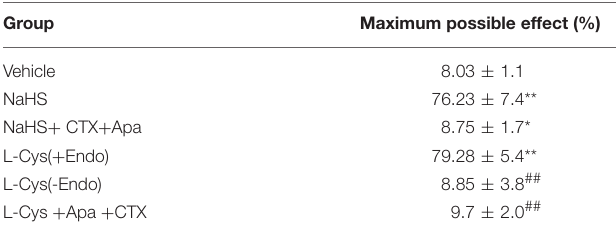
TABLE 1 | Effects of CTX plus Apa on relaxation of MCA to NaHS or L-Cys, and role of vascular endothelium in L-Cys-induced relaxation in the MCA (Mean ± SD, n =